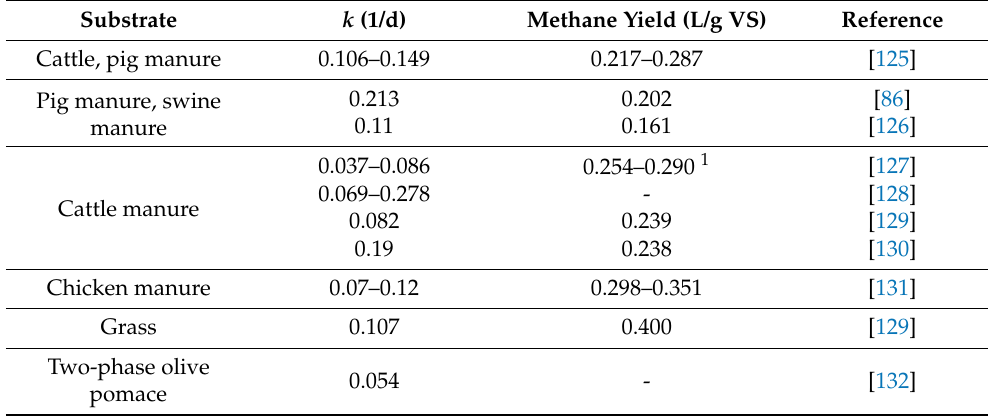
Table 2. Values of first-order decay constant available in the literature at mesophilic conditions.